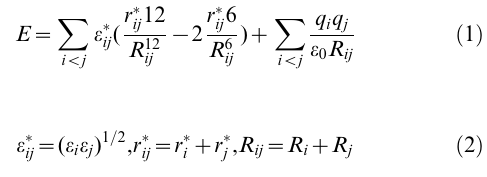
Figure S1 Chemical structures of the 161 host-guest complexes. Figure S2 Chemical structures of the 161 host-guest complexes. Figure S3 Chemical structures of the 161 host-guest complexes. Figure S4 Chemical structures of the 161 host-guest complexes. Figure S5 Chemical structures of the 161 host-guest complexes. Figure S6 Chemical structures of the 161 host-guest complexes. Figure S7 Chemical structures of the 161 host-guest